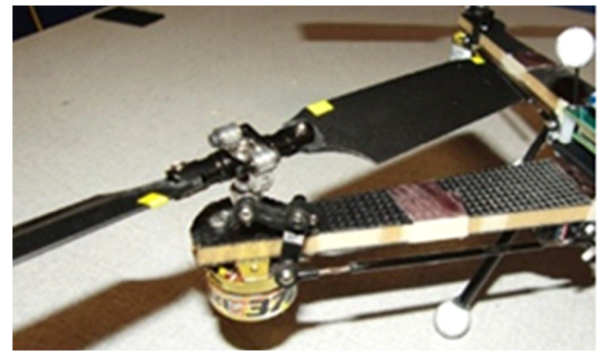
Figure 17. UAVs with variable pitch propellers [57].